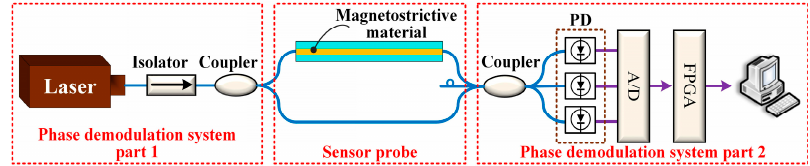
Figure 1. The optical fiber magnetic field sensors based on the magnetostrictive effect. The sensor probe was a Mach–Zehnder fiber interferometer, composed of a 1 × 2 coupler and a 3 × 3 coupler. Both the 1 × 2 coupler and the 3 × 3 coupler adopted bending- resistant fibers. The lengths of the reference arm and the sensing arm were equal